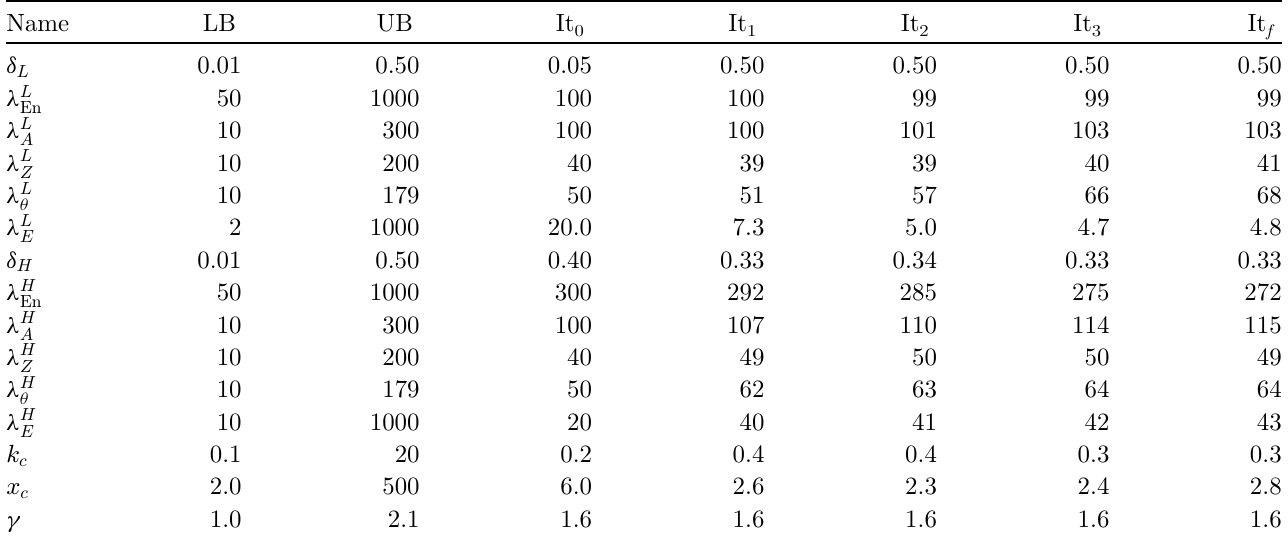
Table 2. Setup of the L-BFGS-B optimization and evolution of hyperparameters. The columns LB and UB give the indicate the parameter values after lower bound and upper bound, respectively, of the parameter ranges. Columns It i i (cid:1) 1000 iterations. The column It contains initial values and It the fi nal values after 3500 f 0